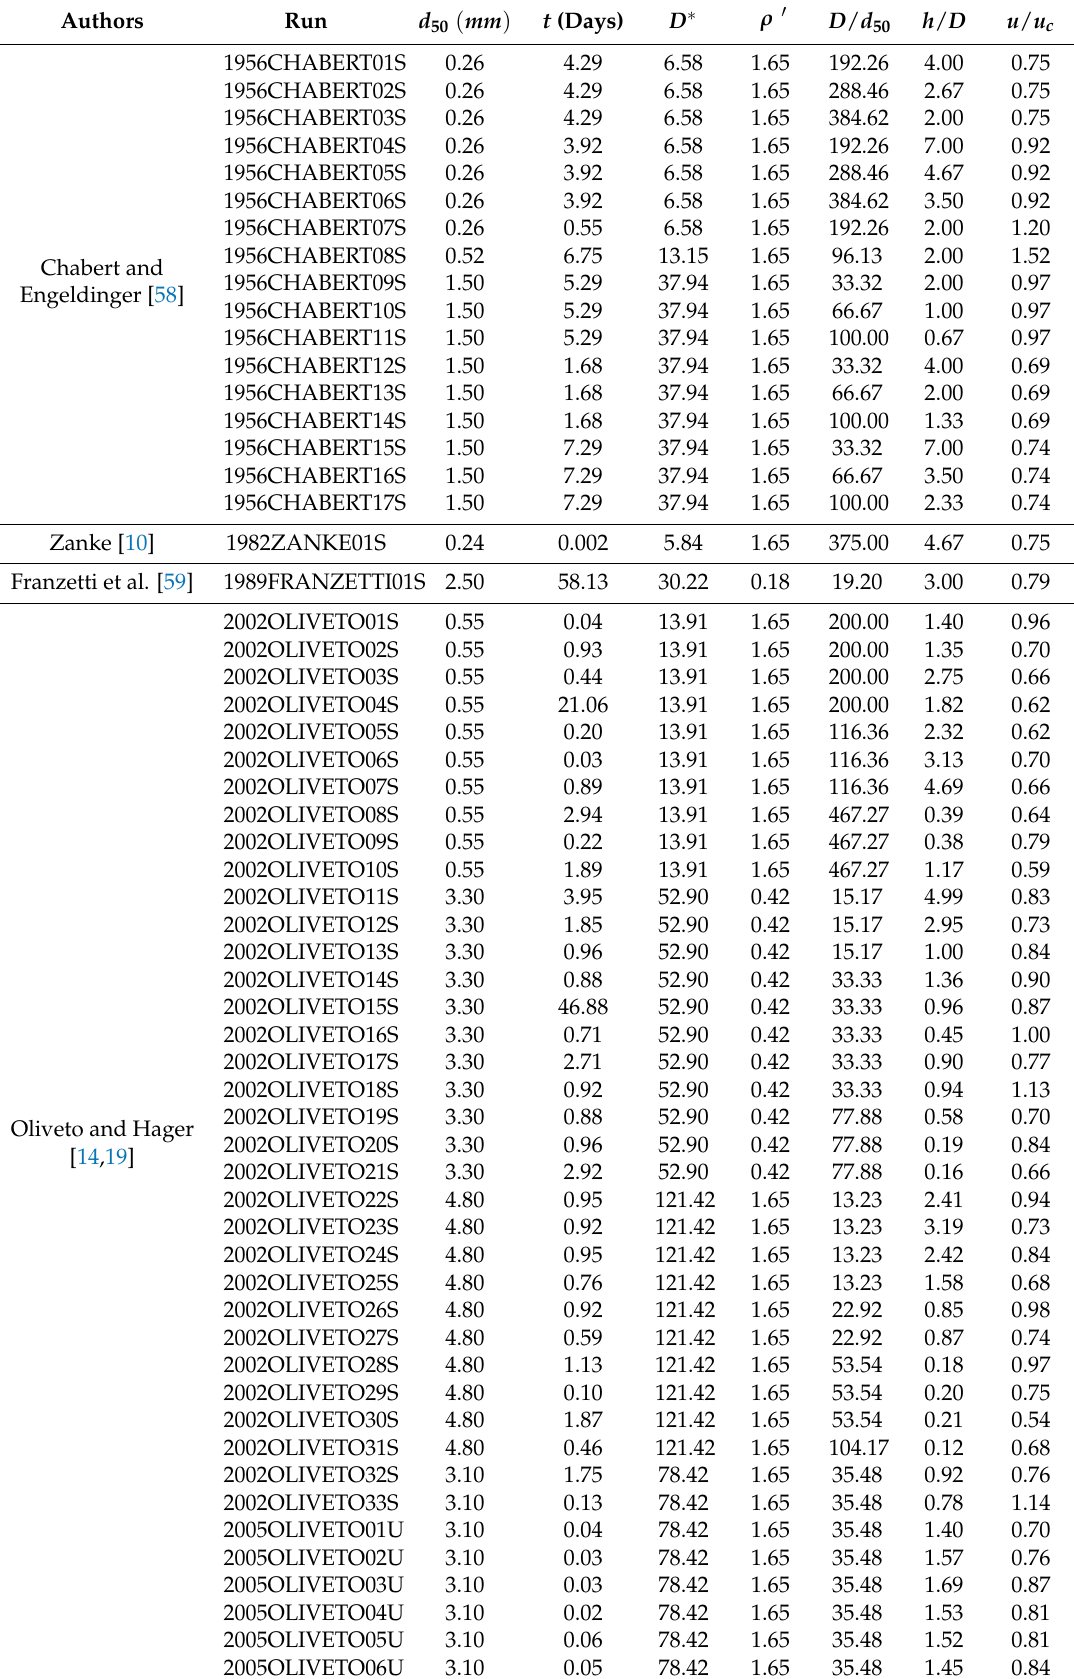
Table 1. Characterization of the experimental data employed for λ